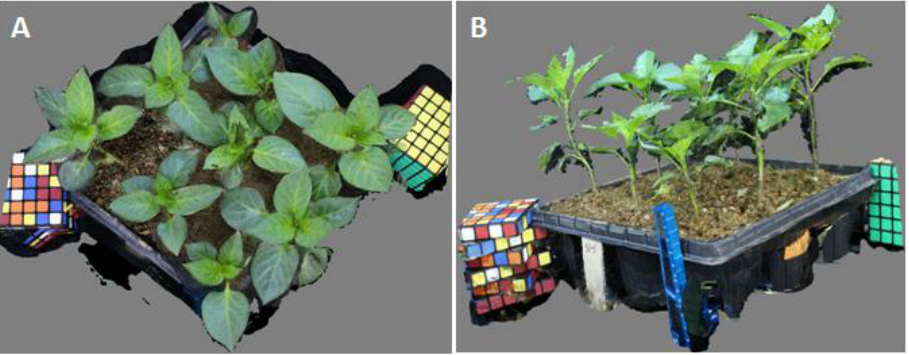
Figure 5. Texture mapping of the best 3D models for paprika plants. ( A ) Leaf models reconstructed from a series of photos taken by a 28-mm lens at the first camera position; ( B ) Leaf and stem models